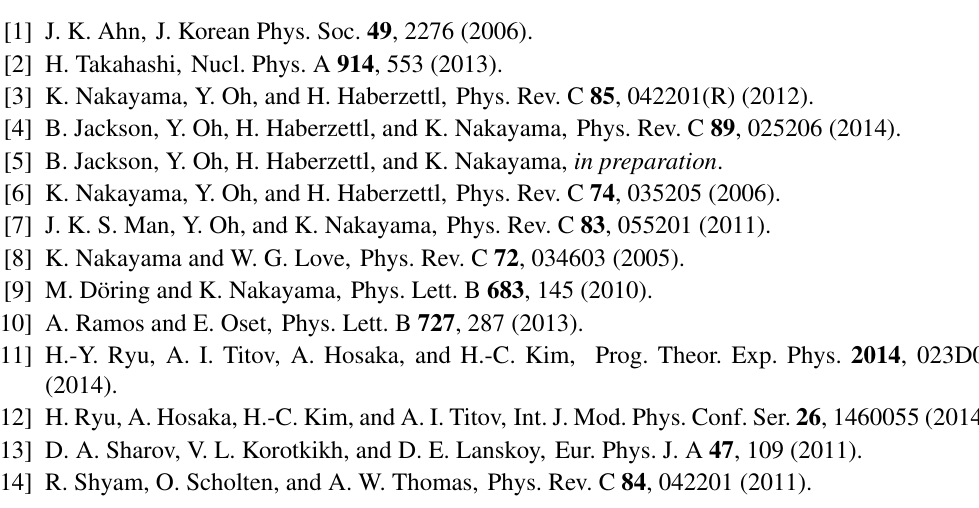
Figure 3. The left and center figures show kaon angular distributions in the center-of-mass frame for K − + p → K + + Ξ − (left figure) and for K − + p → K 0 + Ξ 0 (center figure). The right figure shows d σ K − + p → K + +Ξ − and K − + p → K 0 +Ξ 0 reactions.The blue lines represent the full model results. The numbers in the upper right corners correspond to the centroid total energy of the system, W , in the energy bins. The experimental data are adopted from Ref.